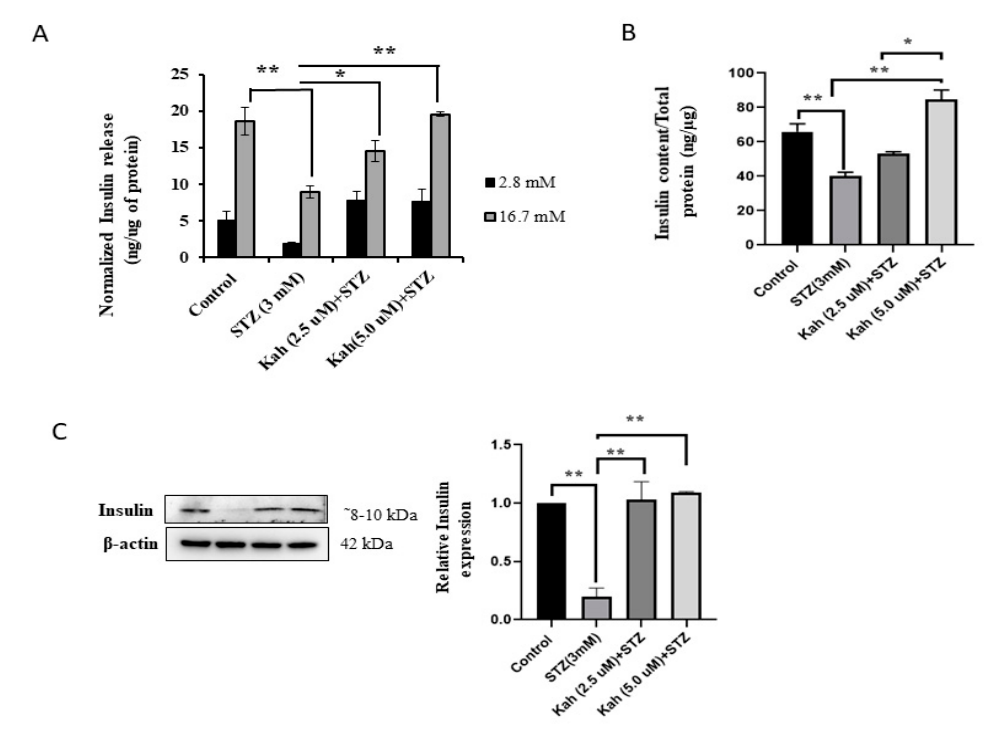
Figure 3. Effect of kahweol on insulin secretion, content, expression, and glucose uptake in STZ-treated cells. ( A ) Normalized stimulated insulin secretion in response to 2.8 mM glucose and 16.7 mM glucose as determined by ELISA in STZ-treated cells for 3 h or cells pre-incubated with kahweol for 24 h followed by STZ-treatment compared to control cells. ( B ) Normalized insulin content measurements from STZ-treated cells for 3 h or cells pre-incubated with kahweol for 24 h followed by STZ-treatment compared to control cells. ( C ) Western blot analysis of INS (insulin) in STZ-treated cells for 3 h or cells pre-incubated with kahweol for 24 h followed by STZ-treatment compared to control cells. β -actin was used as endogenous control. Data are shown from three independent experiments. * p < 0.05, ** and p < 0.01. Bars represent mean ± SD.